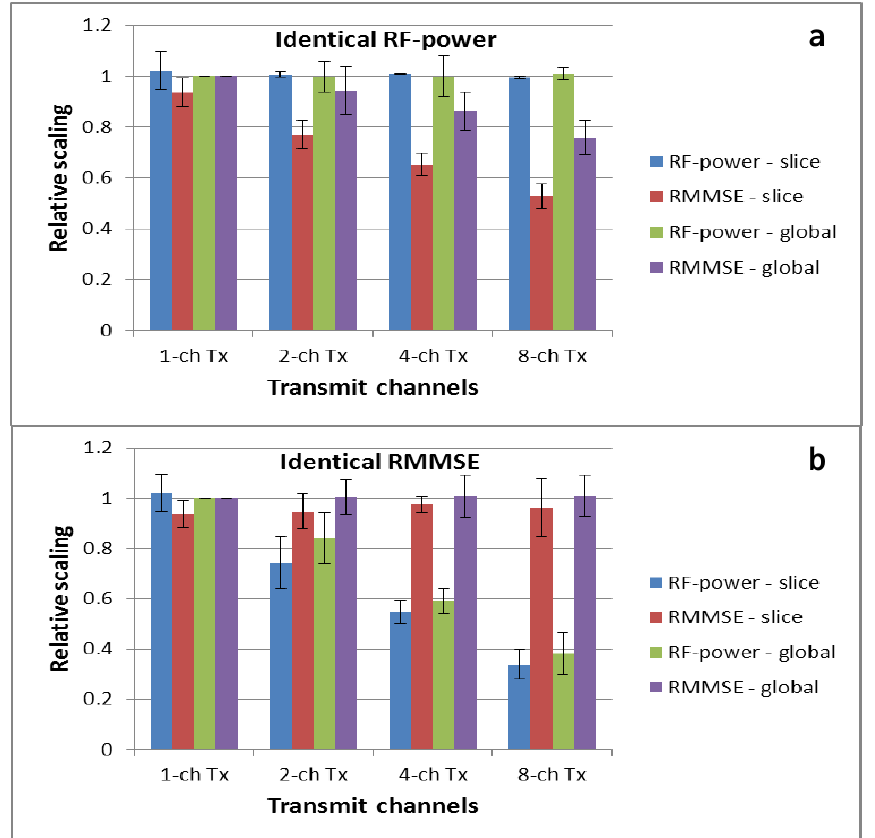
Figure 1. Radio-frequency (RF)-power and root magnitude mean square error (RMMSE), averaged over the volume, for the two shimming methods: slice-selective RF shimming and global RF shimming, for 1, 2, 4, and 8 Tx channels. ( a ) Represents findings when the RF-power was identical for all configurations and ( b ) shows findings when the RMMSE was identical for all configurations. All values have been normalized to the 1-channel Tx mode of the global RF shimming. Error bars represent the standard error over the subjects.